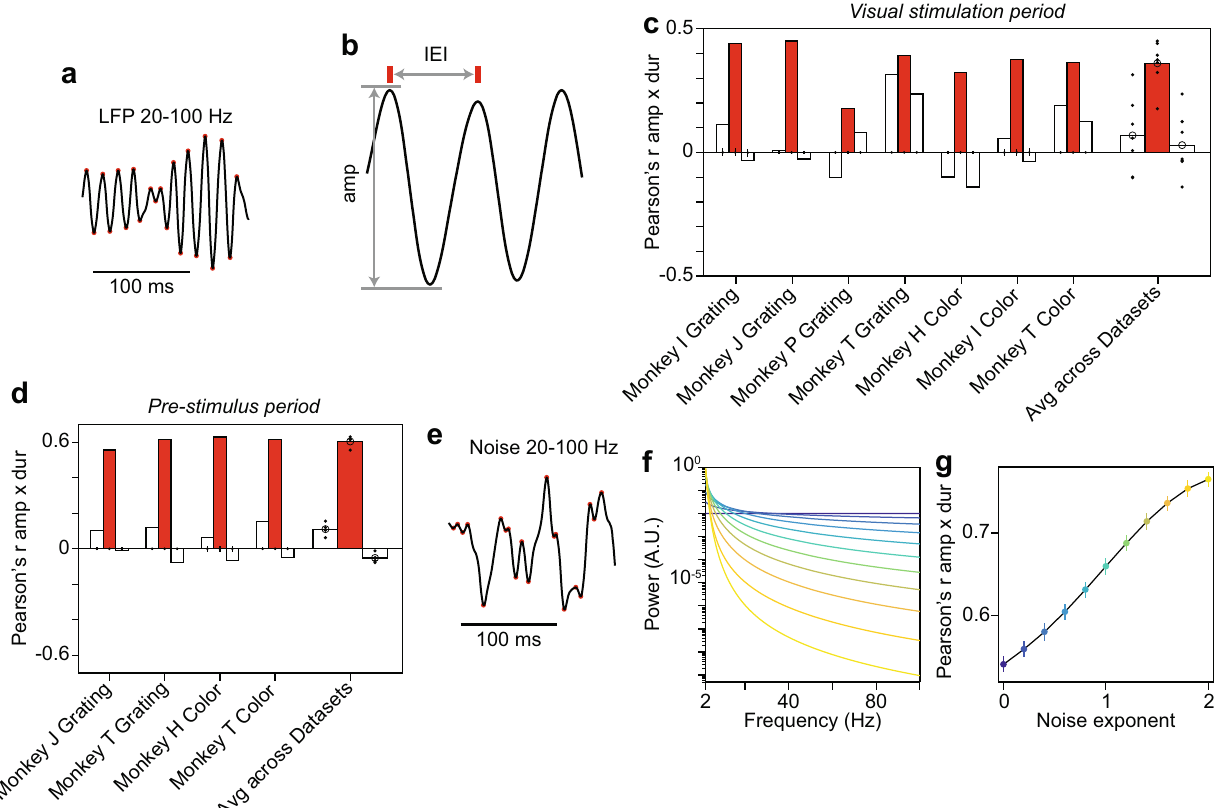
Fig. 2 Estimation of correlation between gamma-cycle amplitude and duration can be in fl uenced by noise. a LFP trace fi ltered in the gamma range (20 – 100 Hz). Red dots indicate local maxima and minima. b Segment of the trace in a demonstrating the de fi nition of gamma-cycle amplitude and inter- event interval, i.e. gamma-cycle duration. c For each dataset listed on the x-axis, the three bars show the correlation between gamma-cycle amplitudes and the durations of the same gamma cycle (center, red), the previous gamma cycle (left, white), and the next gamma cycle (right, white). On the right, this is shown for the average across all datasets. This was calculated for the visual stimulation period. Amplitude and duration values were extracted as in Roberts et al. 31 , including the fi ltering illustrated in a , b ; note that the employed subtraction of a boxcar-smoothed signal amounts to a high-pass- fi ltering at 20 Hz. For each dataset, a null distribution was produced by randomizing the order of duration values across trials, and the resulting means and 99.9% con fi dence intervals are shown as dots and vertical lines (numbers of trials = 278, 5740, 672, 1075, 672, 320, 142 for respective datasets). For the average across datasets, shown on the right, we performed a two-sided t -test and show the resulting con fi dence intervals as vertical lines on the observed mean (red bar: p < 5 × 10 − 5 , white bars for preceding cycle: p = 0.28, white bars for succeeding cycle: p = 0.56). In addition, we performed a two-sided non-parametric permutation test (red bar: p < 0.05; white bars: p > 0.05). n = 6 biologically independent experiments. d Same as c but for the pre-stimulus baseline (numbers of trials = 5740, 1075, 672, 142 for respective datasets; averages across datasets: red bar: p = 4.51 × 10 − 5 , two-sided t -test across datasets; white bars p = 0.011 and p = 0.038, respectively for preceding and succeeding cycles, two-sided t-test across datasets). n = 6 biologically independent experiments. e Example synthetic colored noise trace fi ltered in the gamma range (20-100Hz). Red dots indicate local maxima and minima. f Power spectra of synthetic colored noise signals with a spectral shape of 1/f n , with n assuming values from 0 (dark blue) to 2 (bright yellow). g Correlation of